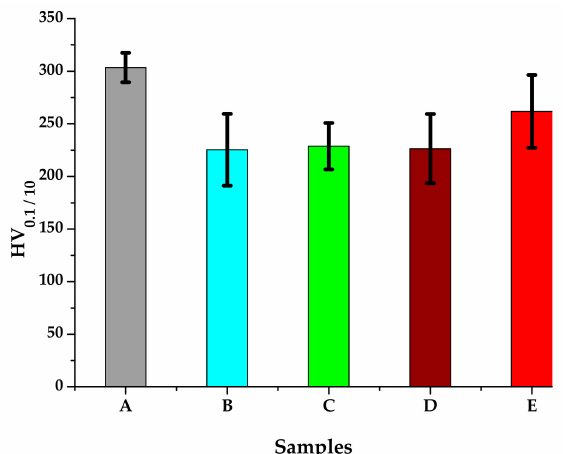
Figure 10. HV 0.1 / 10 average hardness of the 316 AISI modified stainless steel samples.